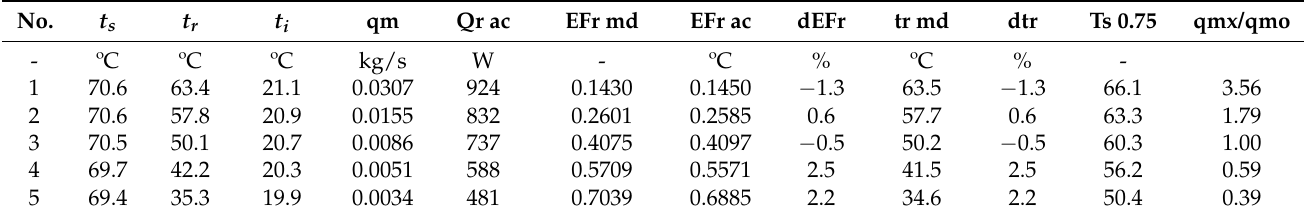
Table 2. The comparison between the measurement and the calculations results Radiator T1. t s = 70 ◦ C. No.